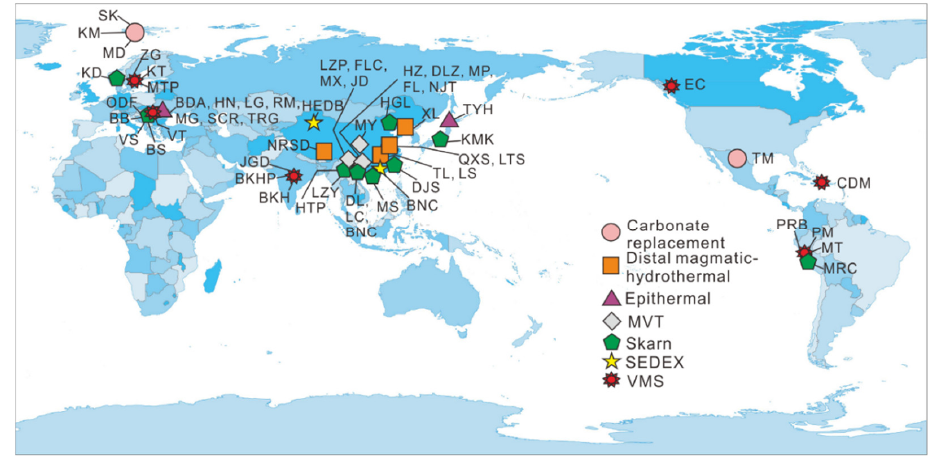
Figure 1. Principal Pb–Zn deposits that reported LA – ICP – MS data of sphalerite. CR type: TM, Tres